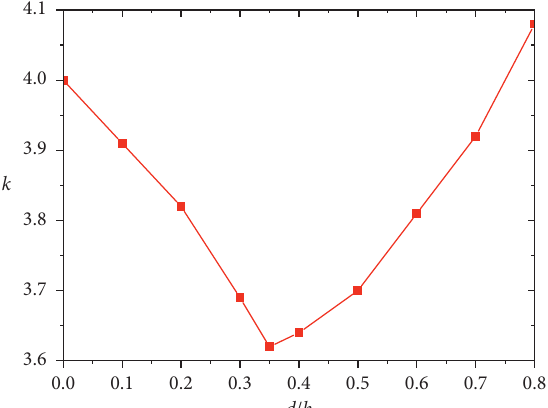
Figure 19: Buckling coefficient of plates with circular holes.